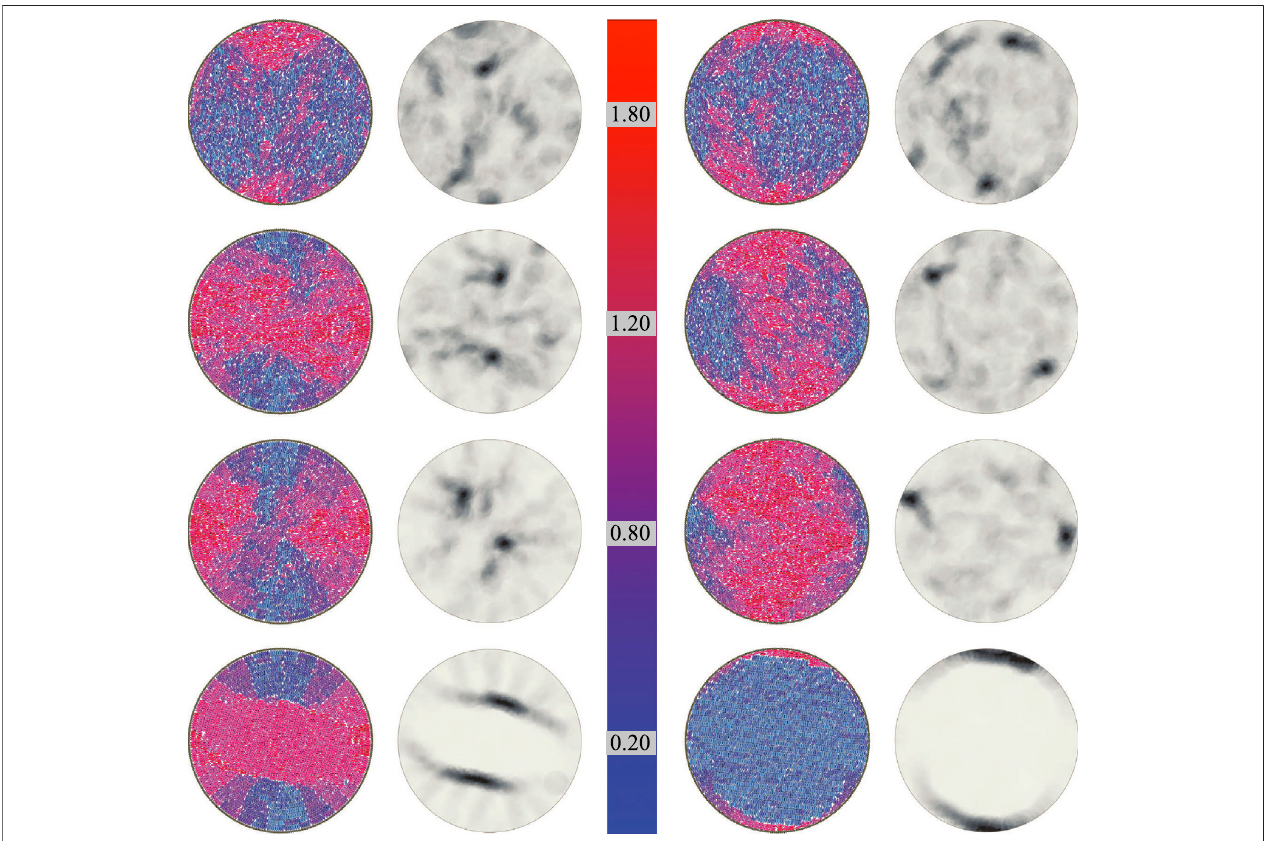
FIGURE 7 | The 2D GB ( 3 , 5 , 2 , 1 ) mesogen system con fi ned by a circular boundary. The series from top to bottom represents a cooling sweep: temperature is indicated by the centered temperature bar. Renditions are shown for homeotropic ( ε h / ε p (cid:2) 5 . 0, two leftmost columns) and planar ( ε h / ε p (cid:2) 0 . 2, two rightmost columns) anchoring. Each set of columns on either side of the temperature bar correspond as follows: con fi guration snapshots (left) and scalar fi eld of the local order parameter (right) .